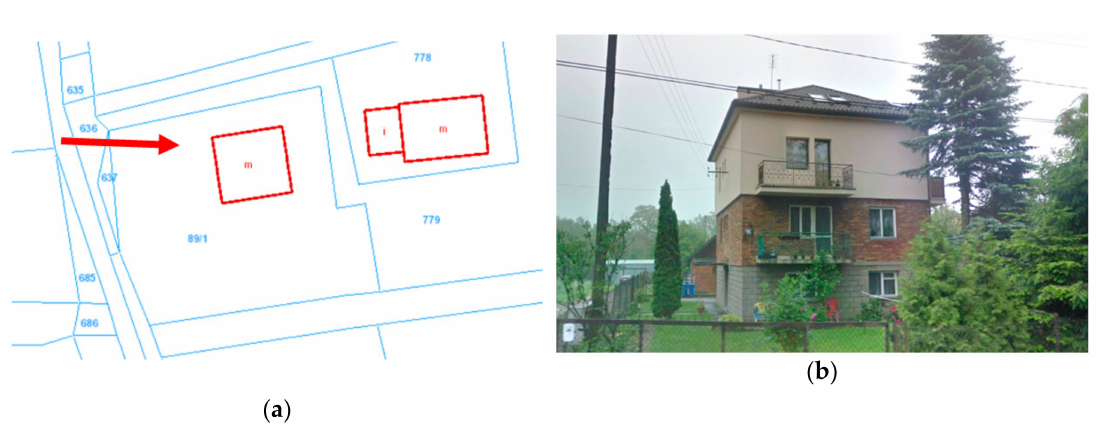
Figure 10. Example of the building no. 89 / 1;1 with two separate premises constituting independent properties. ( a ) Building on the cadastral map; ( b ) photo of the